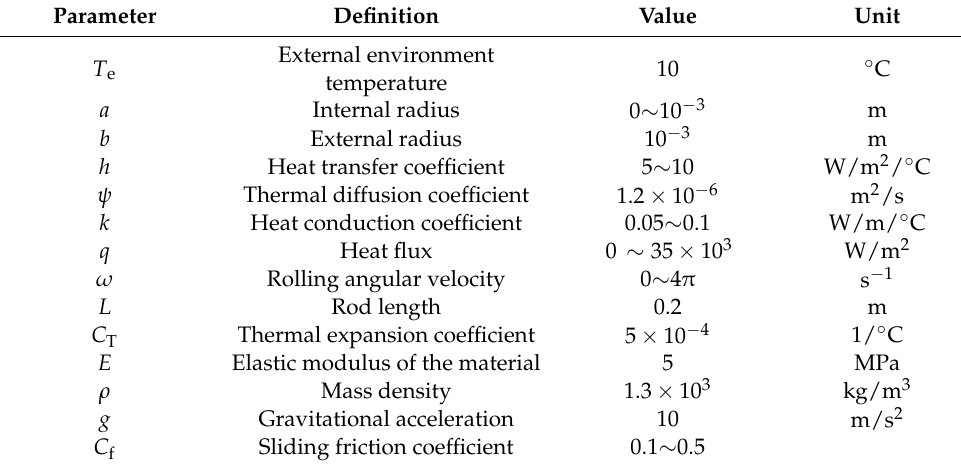
Table 1. Material properties and geometric parameters.